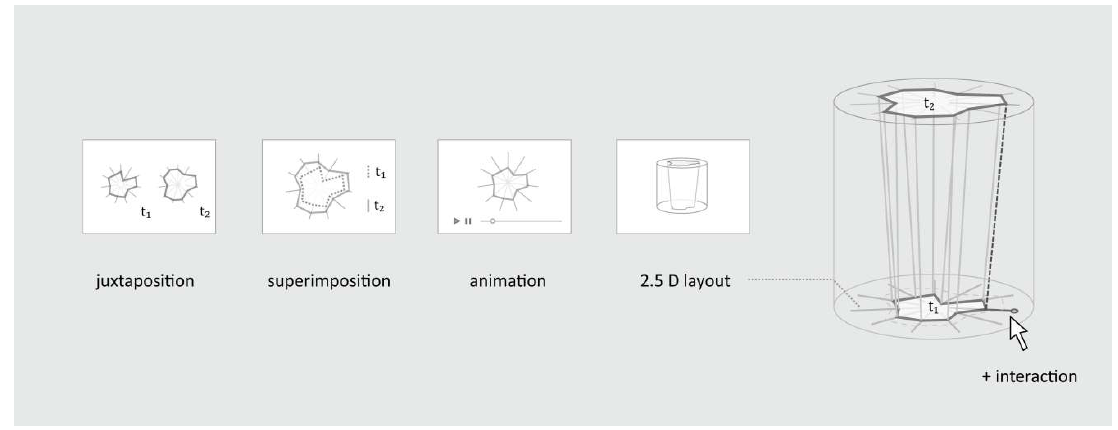
to t ), including juxtaposition, 1 2